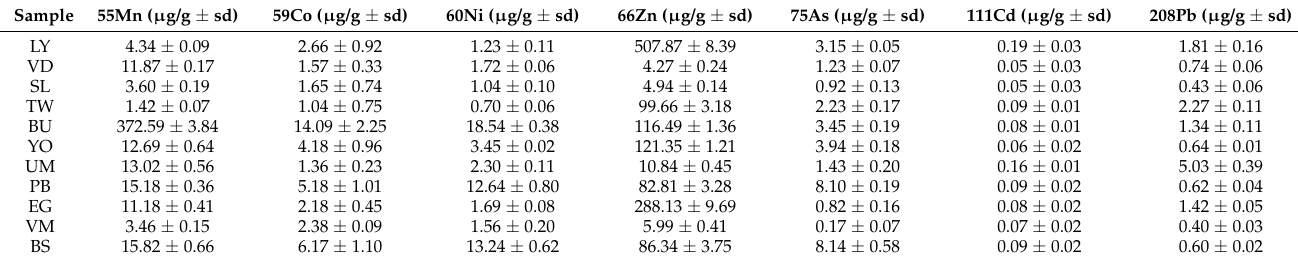
Table 4. Amounts of heavy metals found in acrylic color paints commonly used by the school